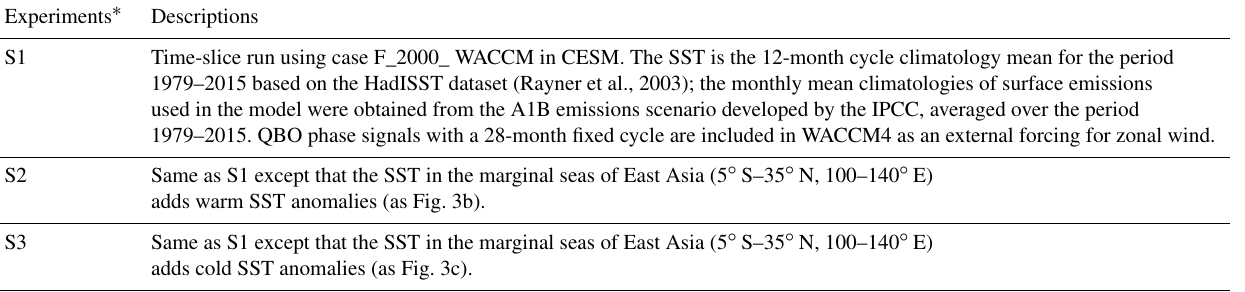
Table 2. Experiments S1–S3.